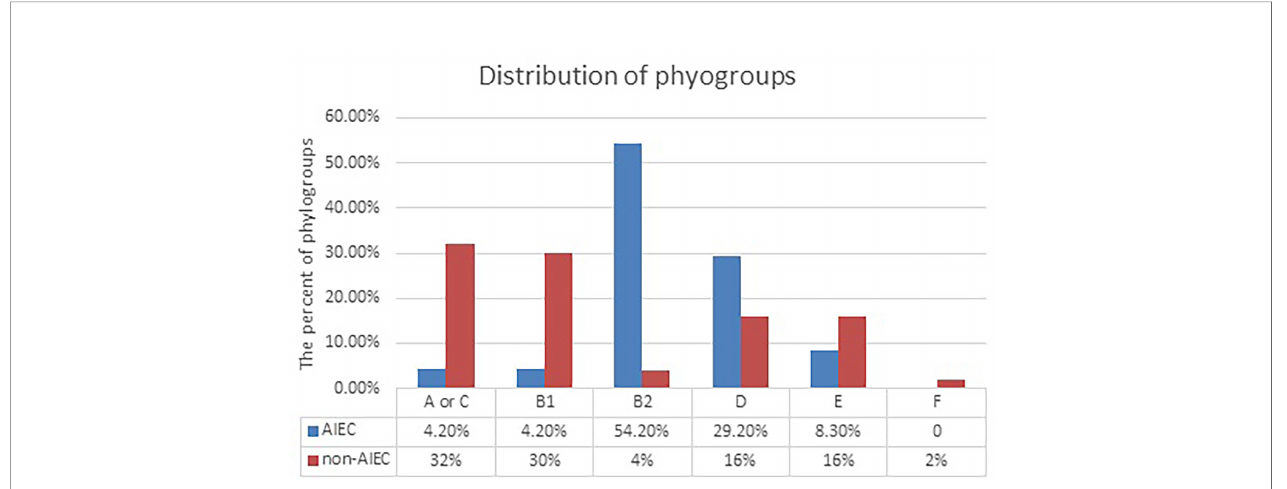
FIGURE 1 | Distribution of adherent – invasive Escherichia coli (AIEC) and non-AIEC isolates according to phylogroups. Data were analyzed using chi- square test. S , signi fi cant (*<0.05); NS , not signi fi cant for null ( p > 0.05) association.